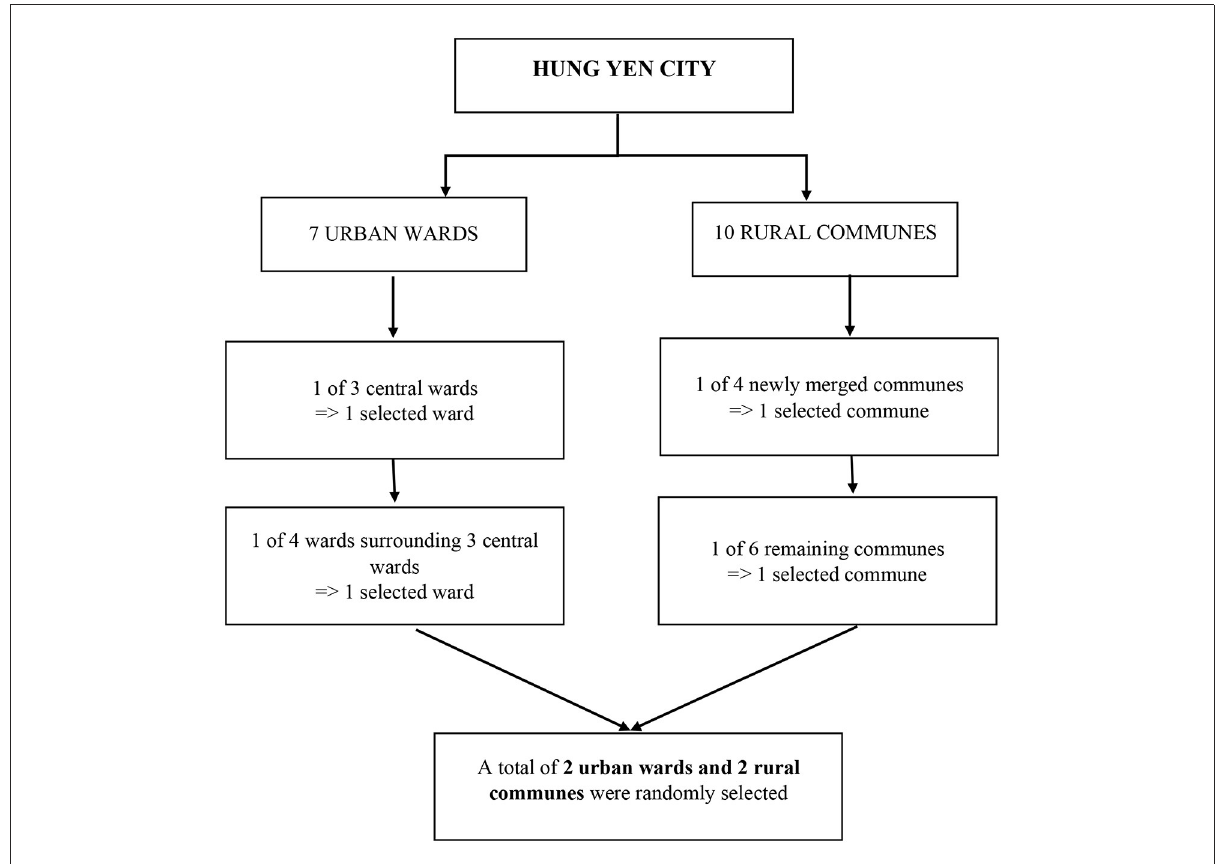
FIGURE1 Systematic random sampling technique in the study.